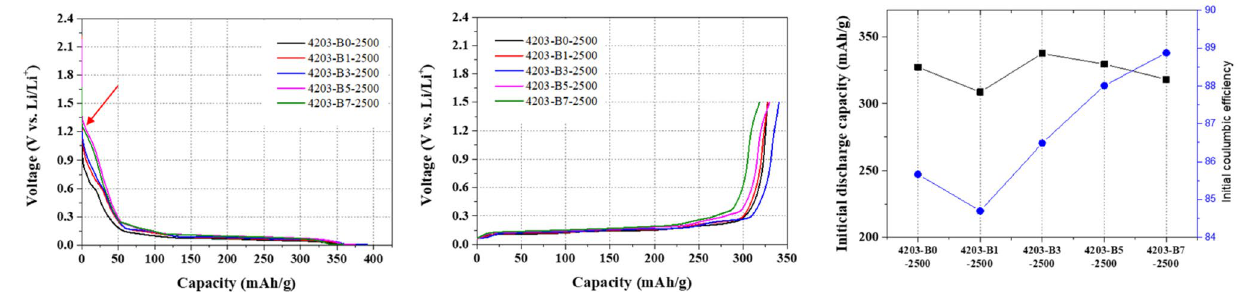
Fig. 8 Initial charge–discharge profile and coulombic efficiency of 4203-BX-2500